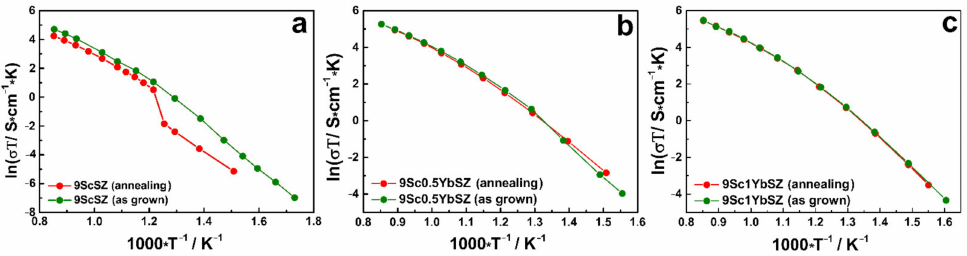
Figure 4. Conductivity of as-grown and as-annealed ( a ) 9ScSZ, ( b ) 9Sc0.5YbSZ, and ( c ) 9Sc1YbSZ crystals as a function of